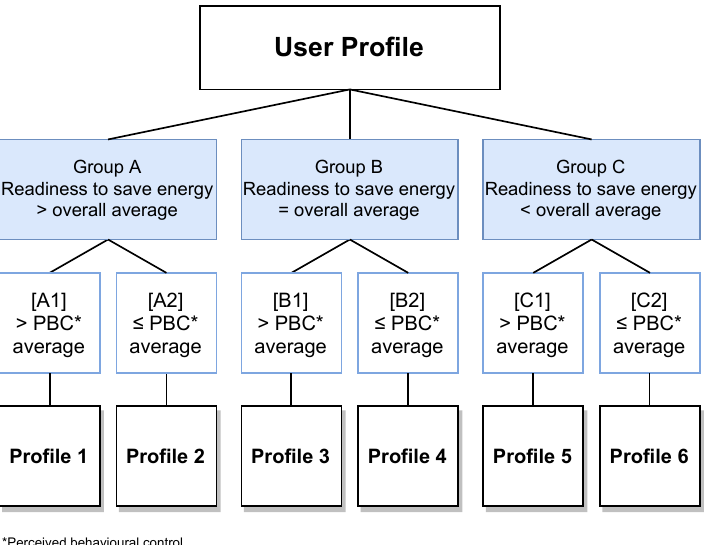
Figure 8. User profiling decision